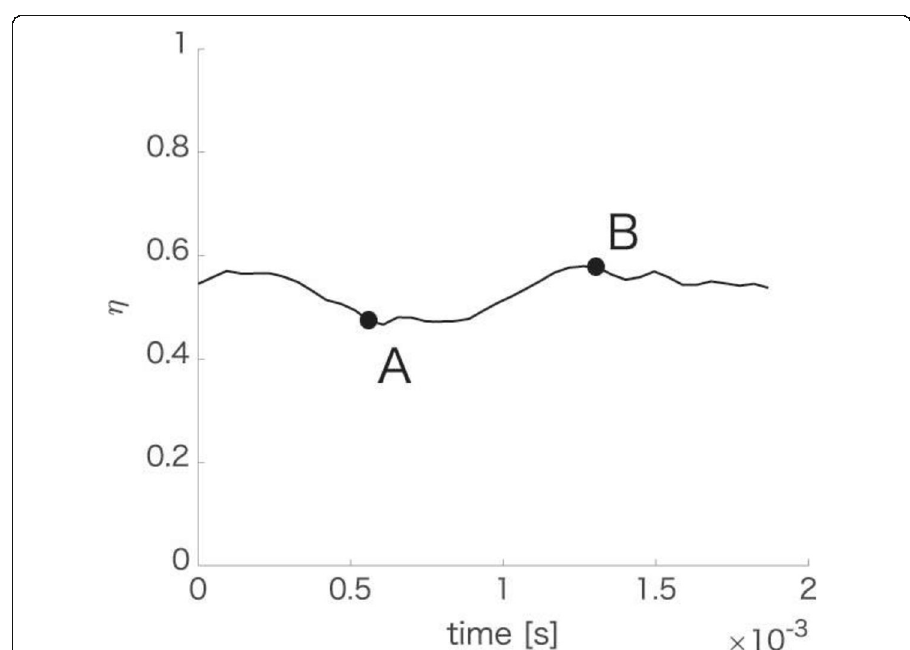
Fig. 4 Time history of the cooling effectiveness